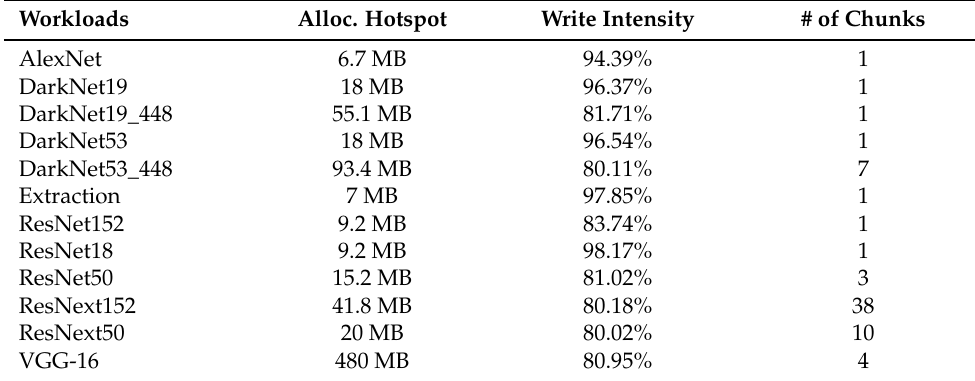
Table 3. Hotspot size and number of memory chunks.